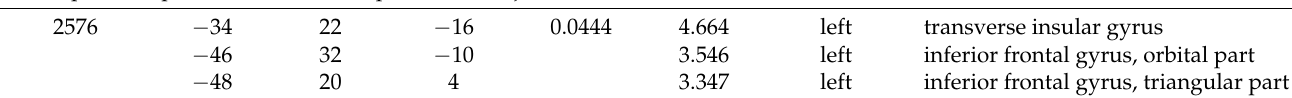
Table 4. Significant clusters of mismatch-related activity irrespective of introspection or object feature identification (Figure 4, red region) and psychophysiological interaction analysis with the left inferior frontal gyrus as the seed region (Figure 4, green region). The locations of local maxima were